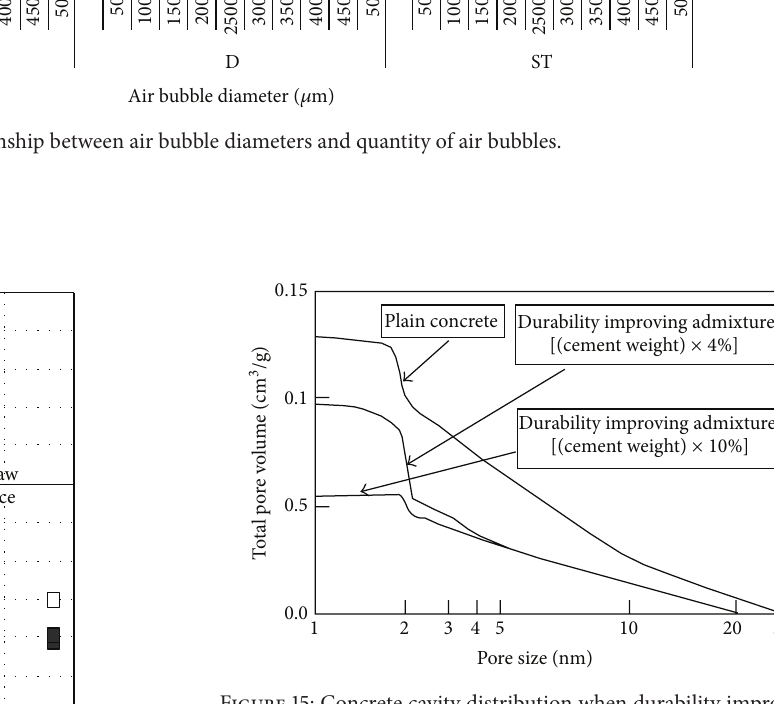
Figure 15: Concrete cavity distribution when durability improving admixture is used.